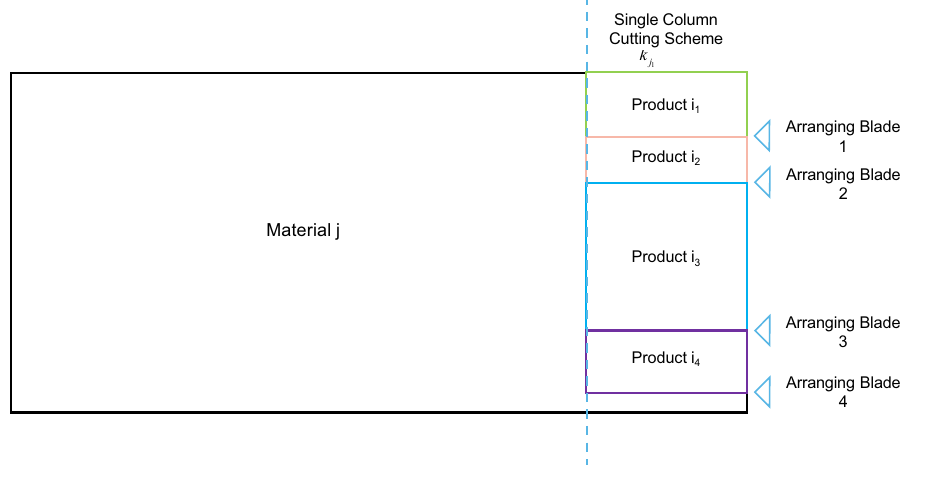
Figure 7. Schematic diagram of single column cutting